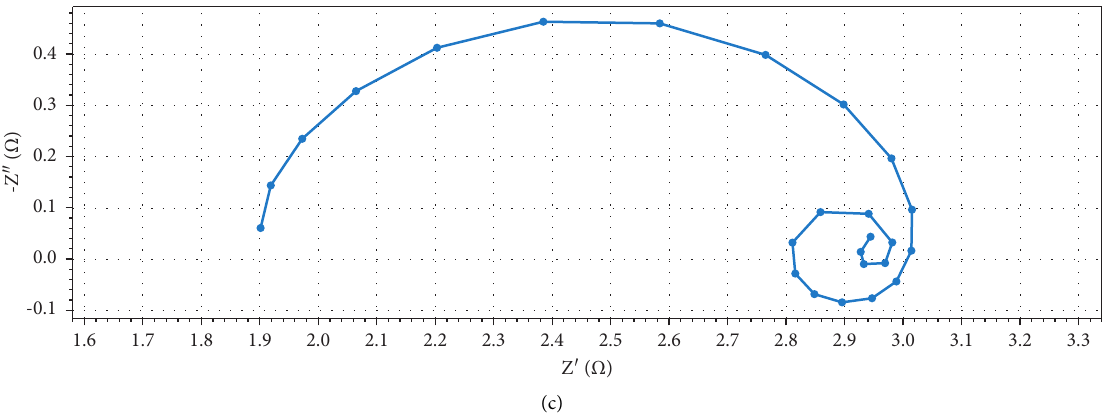
Figure 7: Electrochemical impedance spectra (Nyquist plot) of WC-flyash-coated GrA1